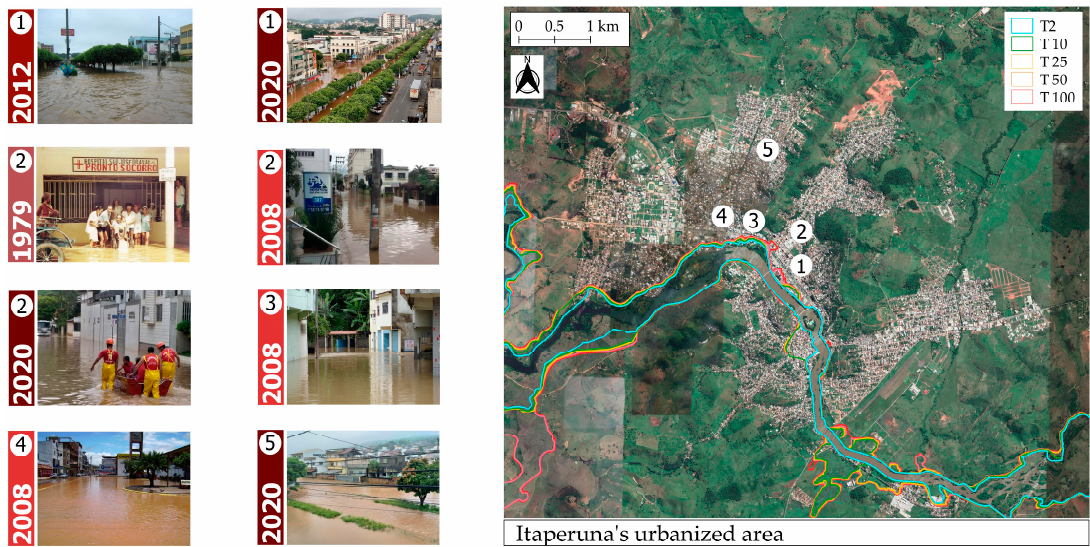
Figure 12. Flood susceptibility map (based on transitory factors) of Itaperuna for different return periods (2, 10, 25, 50, and 100 years), and some photographic records of historical flood spots.